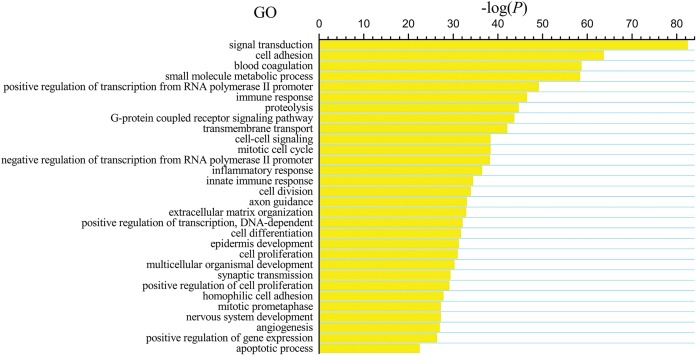
Key gene ontology (GO) terms of differentially expressed intersection mRNAs (the bar plot shows the enrichment scores of the significant enrichment GO terms).